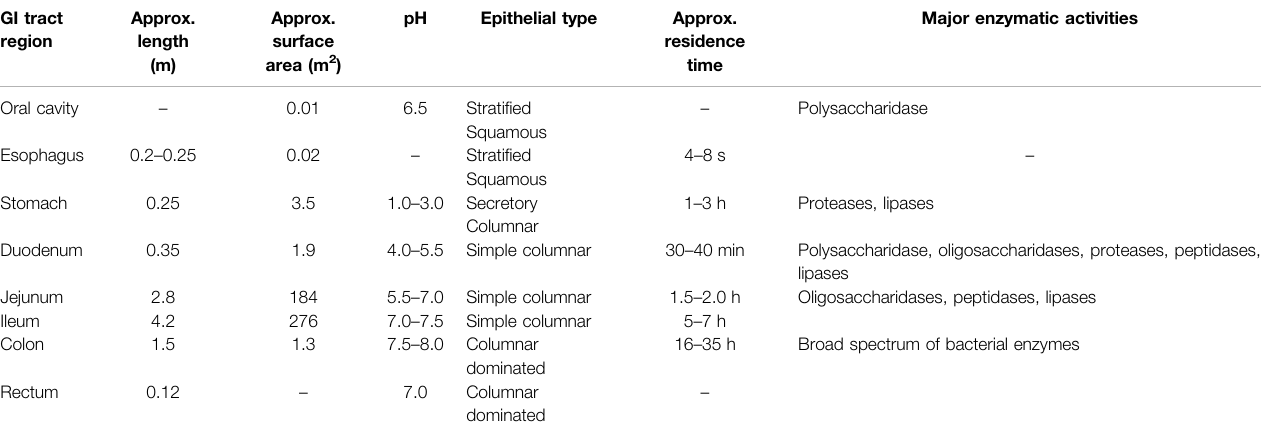
TABLE 1 | Physiological features of the human gastrointestinal tract. GI tract